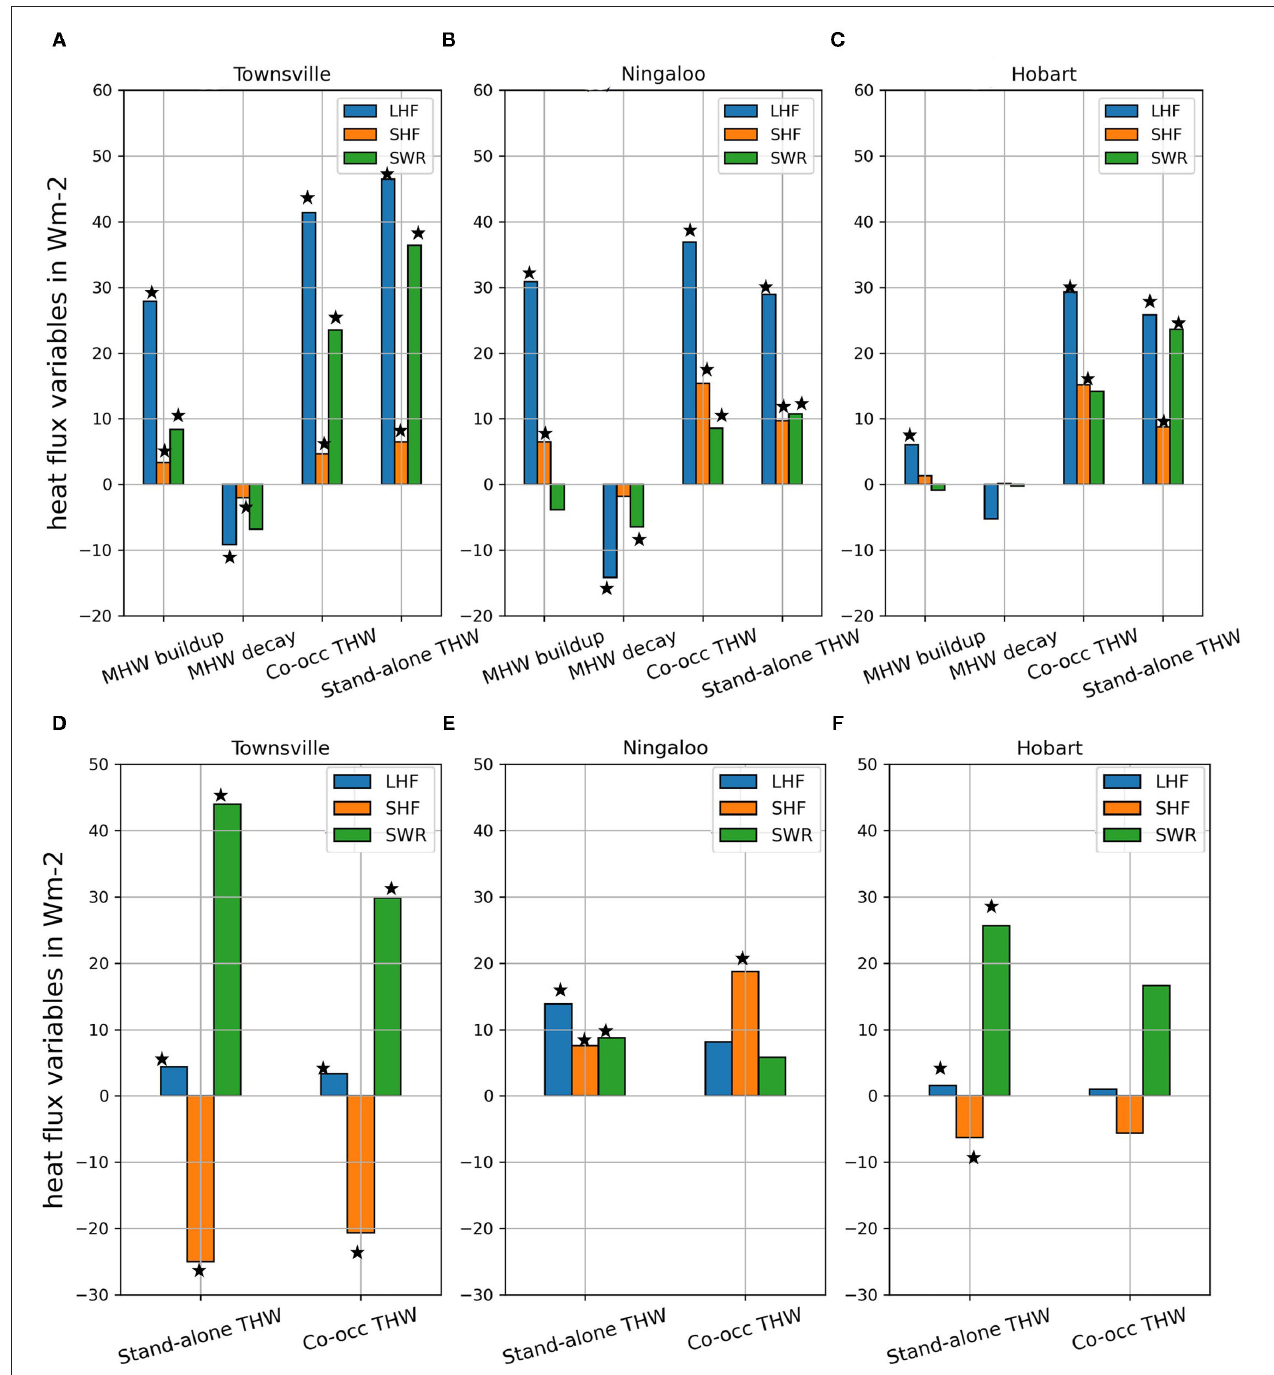
FIGURE 8 | Composite means of latent heat flux, sensible heat flux and shortwave radiation anomalies over ocean points during stand-alone MHW, build-up and decay phases, co-occurring THWs and stand-alone THWs for (A) Townsville, (B) Ningaloo and (C) Hobart; composite means of latent heat flux, sensible heat flux and shortwave radiation anomalies over adjacent land points during stand-alone THW and co-occurring THWs for (D) Townsville, (E) Ningaloo and (F) Hobart. Negative LHF and SHF implies a flux of heat from the land/ocean surface to the atmosphere. Asterisks indicate that the composite mean is significantly different from 0 ( p < 0.05) based on a Student t